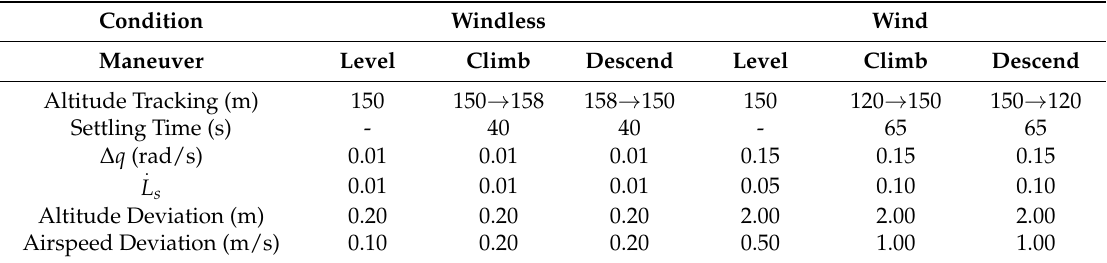
Table 4. A summary of OECS performance for different flight maneuvers and flight conditions.